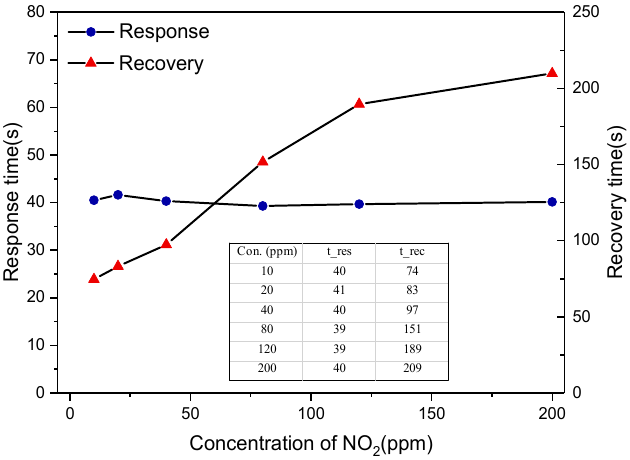
Figure 7. Response and recovery time of Sensor C to different concentrations of NO 2 .